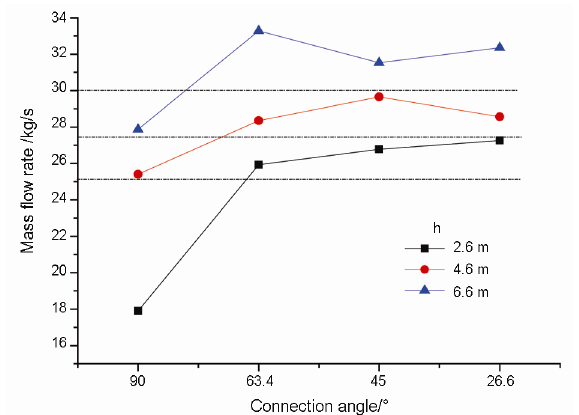
Fig. 12. Mass flow rate of smoke exhausted by the